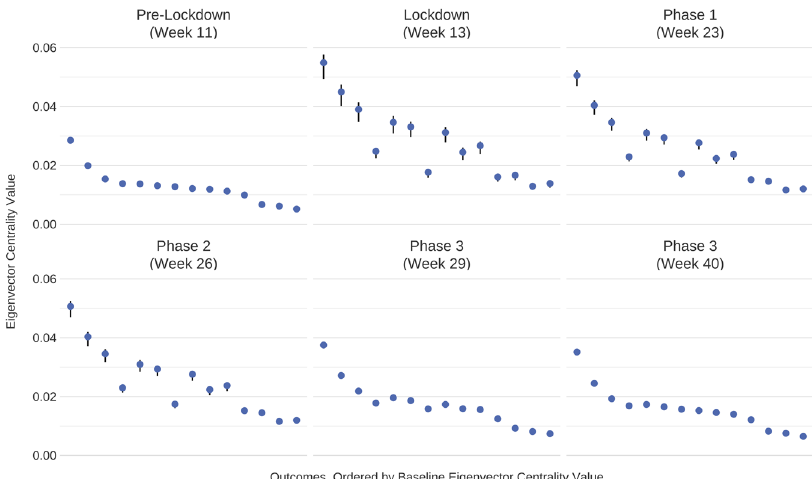
Fig. 3 Distribution of EC values for nodes in the Outcomes level; in descending order of baseline values, with error bars indicating sensitivity – see Methods section. Outcomes in weeks 13, 23, 26, 29, and 40 are all plotted in the same fi xed location to demonstrate which Outcomes fall or rise in EC value, throughout the modelled